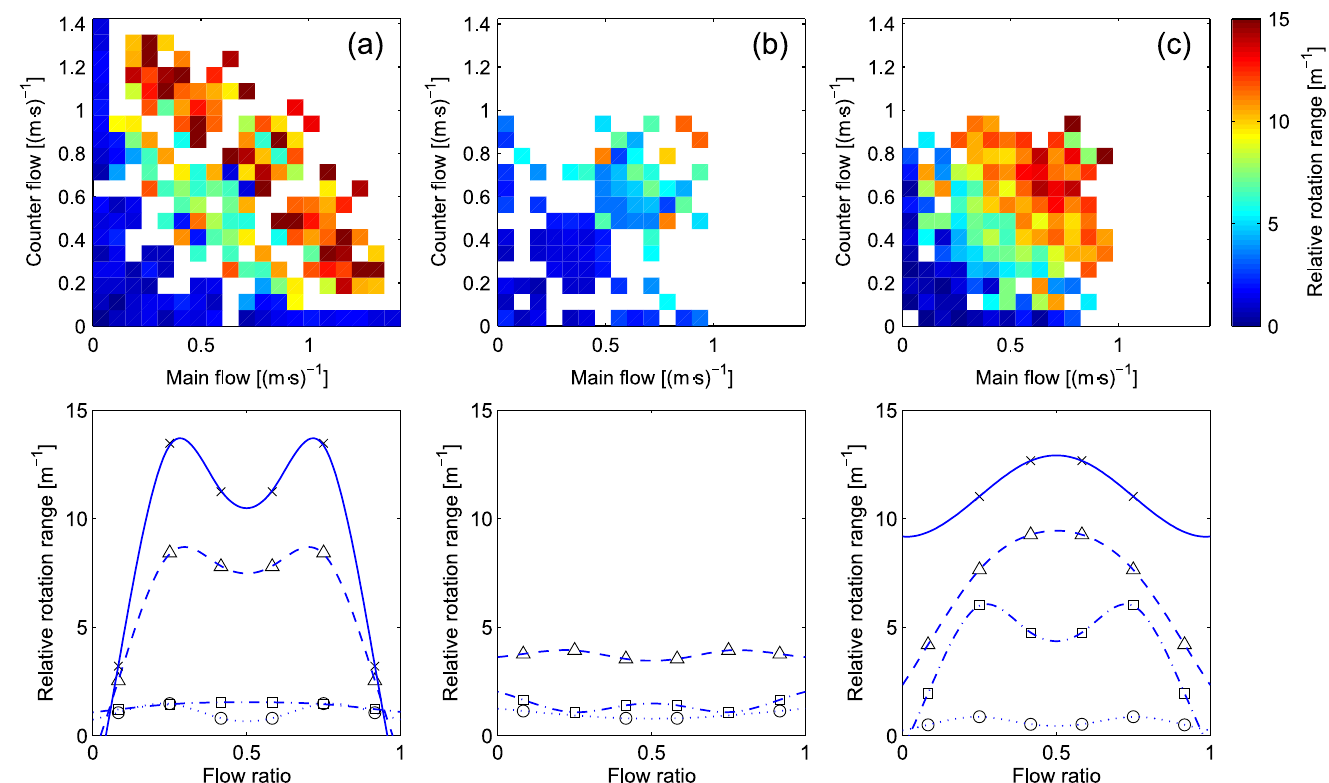
Fig 9. Relative rotation range. The same color scale is used for all scatter plots. Interpretation for the flow ratio representation is provided in Table 4.